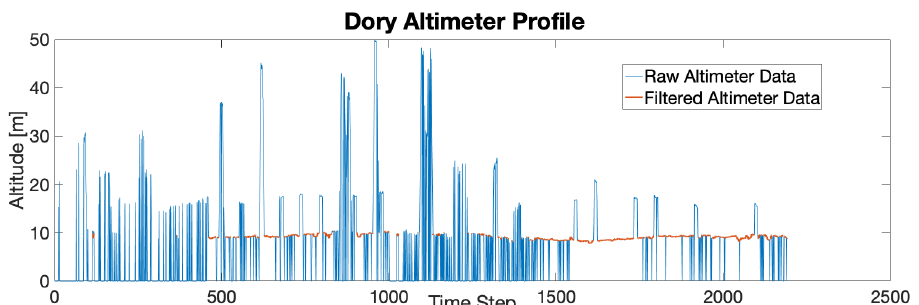
Figure 5. Dory’s altimeter profile from Mission 4. The blue line represents the raw altimeter data. The red line shows the filtered data after outlier rejection and Kalman filtering. Note that the reservoir is believed to have a maximum depth of 16 m.